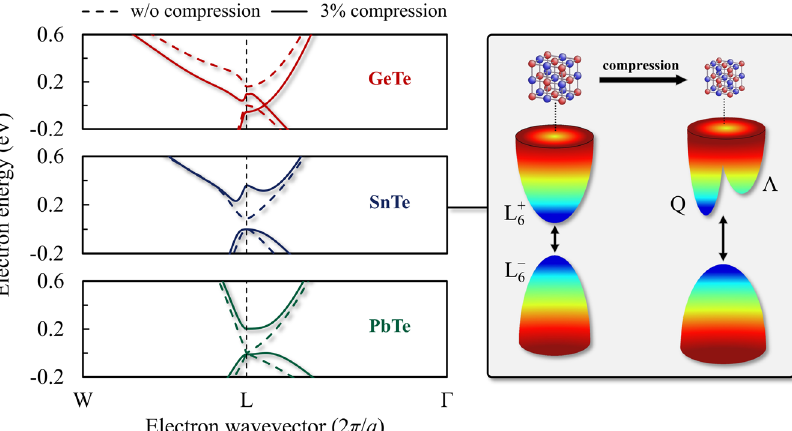
Fig. 1 Evolution of band structures due to different compressive strains. The left plots show the ab initio electron band structures of GeTe (red), SnTe (blue), and PbTe (green). The solid and dashed lines represent the crystal with and without a 3% compressive strain, respectively. The right plot schematically illustrates the transition of the band structure of SnTe after compression. The bottoms of the two new-formed conduction valleys in SnTe are denoted as Q (located at 0.4831 b 1 + 0.5169 b 2 + 0.5000 b 3 in the direction from the L to W point) and Λ (located at 0.4575 b 1 + 0.4575 b 2 + 0.4575 b 3 in the direction from the L to Г point), where b is the reciprocal lattice